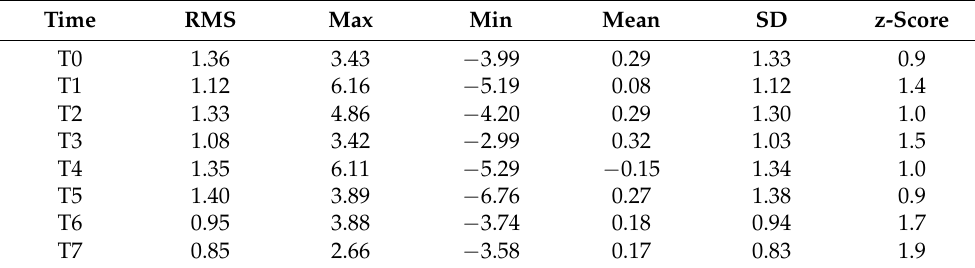
Table 1. RMS, mean, minimum (min), maximum (max), and standard deviation of point-to-point distance between the two models in eight different time points. The corresponding z-scores obtained by the comparison with data from adult twins are reported. Time